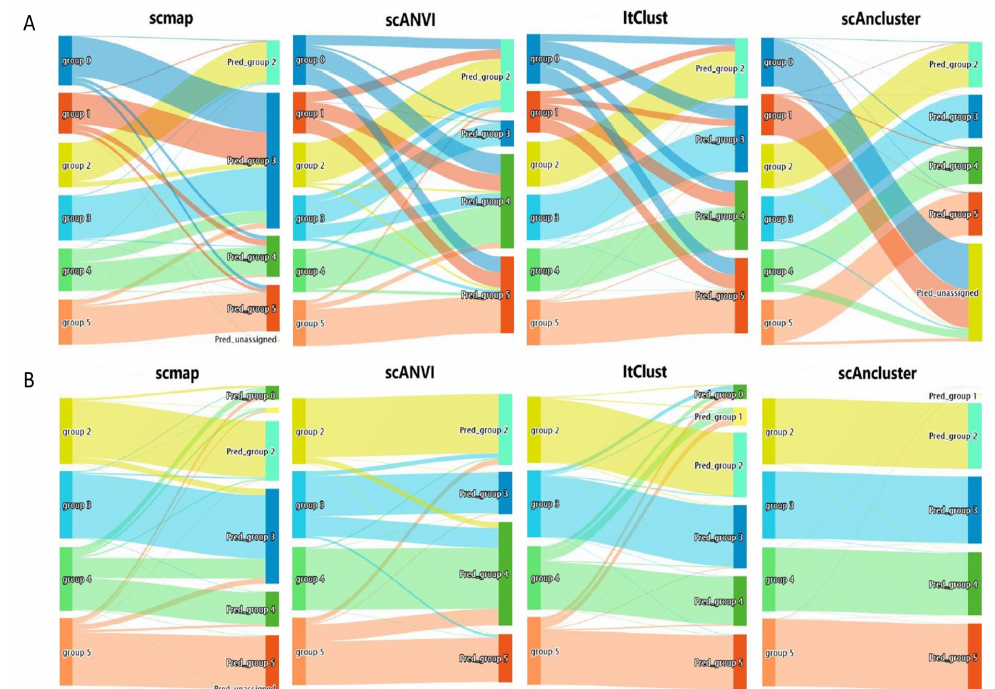
Figure 3. Simulation dataset analysis. ( A ) Sankey plots for four methods on one mixed dataset that removes group 0 and group 1 in the source dataset. ( B ) Sankey plots for four methods on one mixed dataset that removes group 0 and group 1 in the target